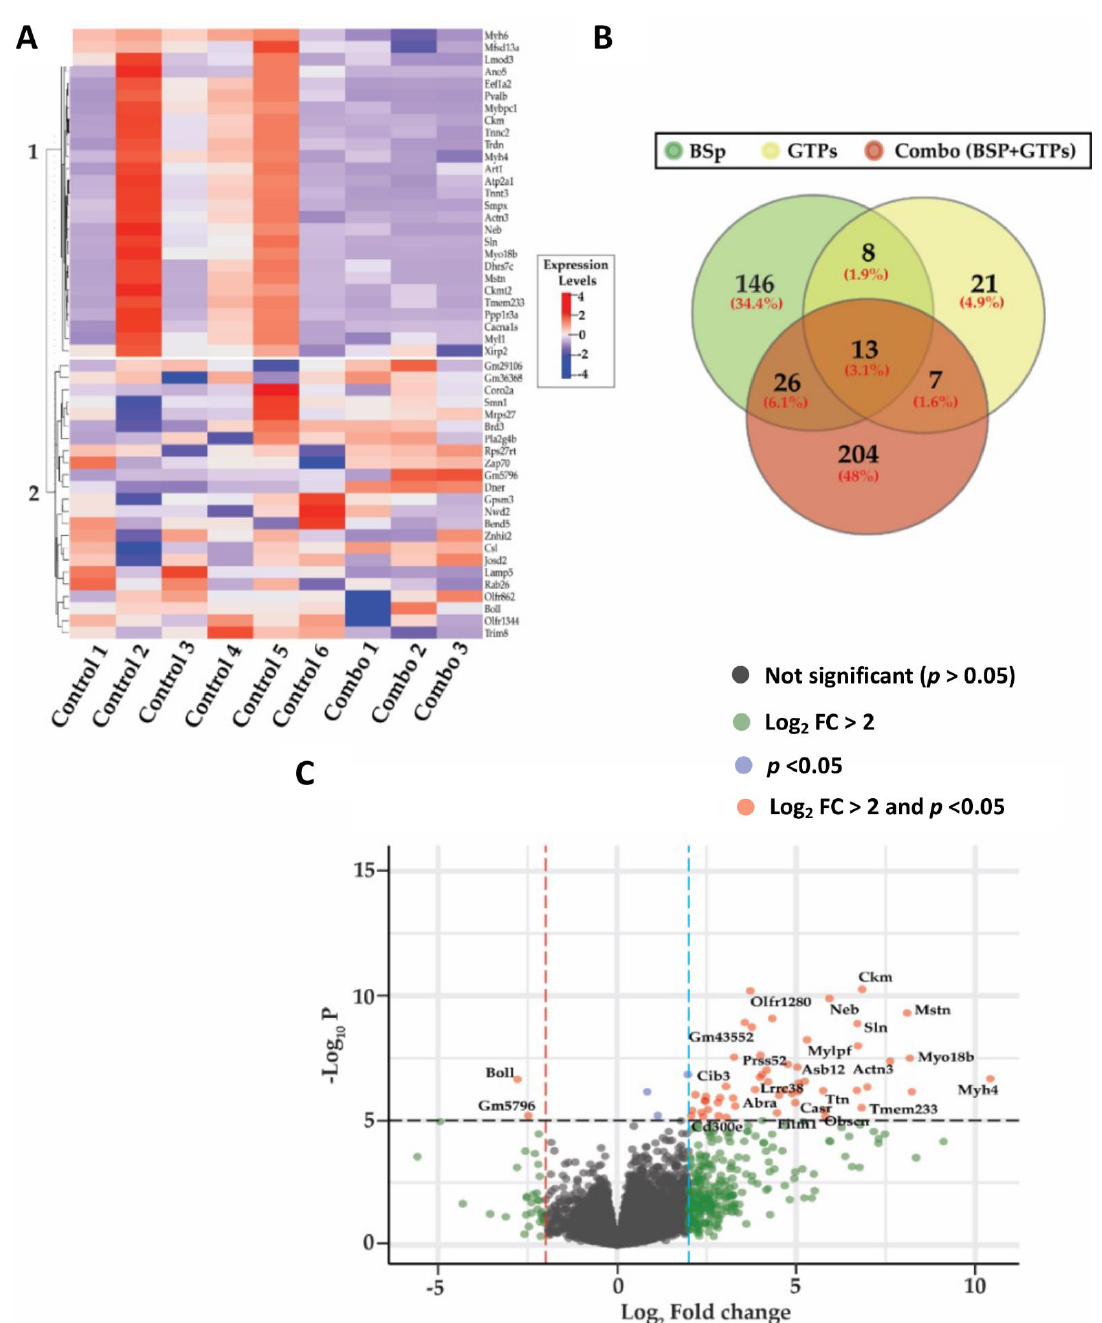
Figure 3. Transcriptomic-level changes across BSp, GTPs and combination (BSp + GTPs) treatment groups. ( A ) Heatmap represents top 50 DEGs in the combination (BSp + GTPs) treatment group, where each row corresponds to differentially expressed transcripts and each column represents sample replicates in control (N Control = 6) and the combination (N Combination = 3) group across two heatmap clusters. Blue indicates lower expression levels, and red denotes higher expression